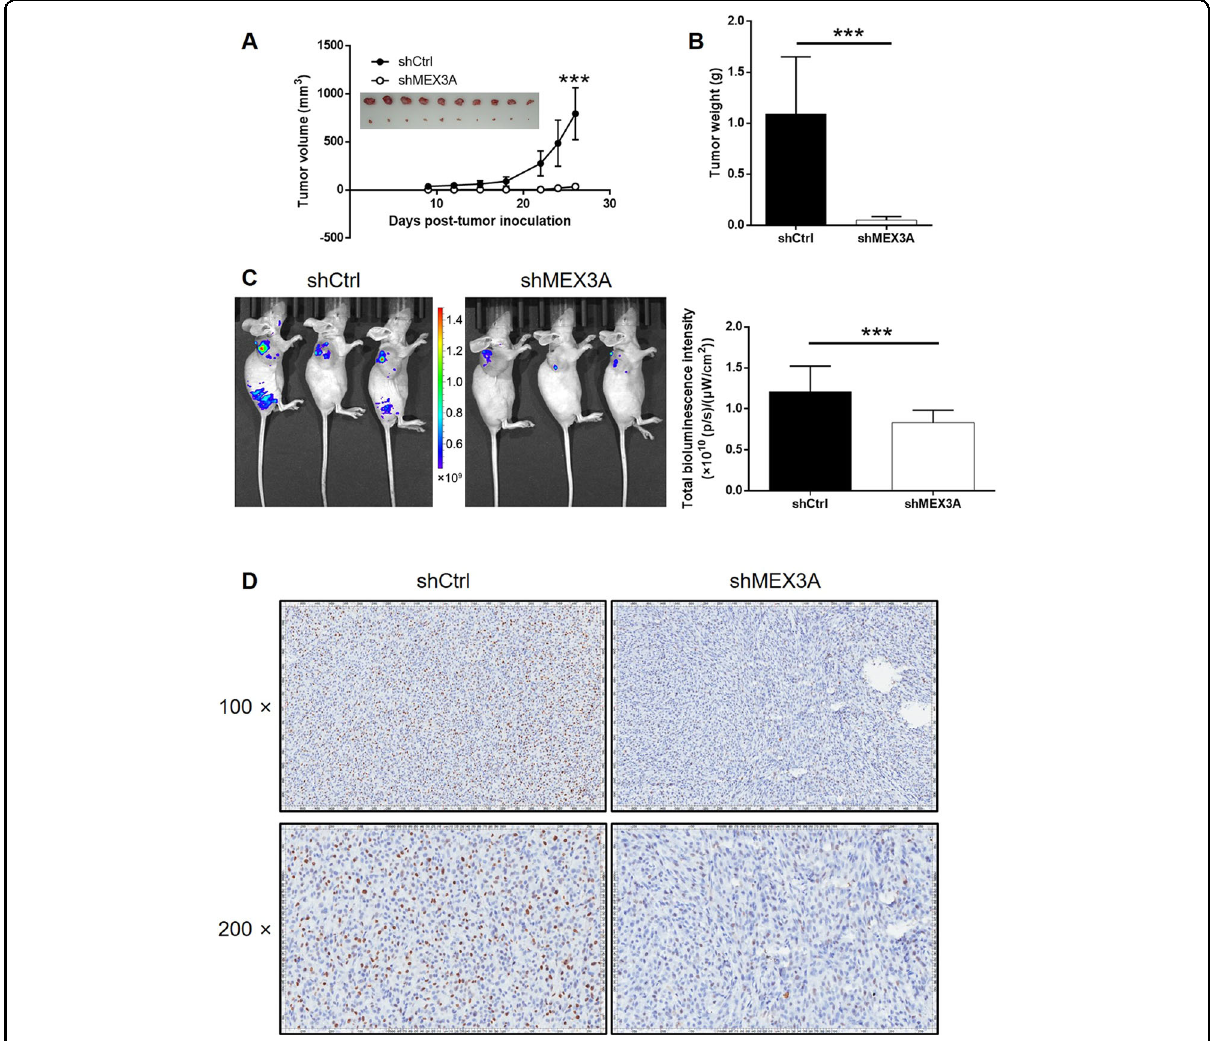
Fig. 3 MEX3A knockdown inhibited glioma development in vivo. A Seven days post injection of U251 cells with or without MEX3A knockdown, the volume of tumors formed in mice was measured and calculated at the indicated time intervals. Inset: tumors were removed 26 days post injection for collecting photos. B Mice were sacri fi ced at day 26 post injection, and the tumors were removed for weighing. C In vivo imaging was performed to evaluate the tumor burden in mice of shMEX3A and shCtrl groups at day 26 post tumor inoculation. The bioluminescence intensity was scanned and used as a representation of tumor burden in mice of shMEX3A and shCtrl groups. D The expression of Ki-67 was detected by IHC to show the proliferative activity of tumors. Data were shown as mean ± SD. * P < 0.05, ** P < 0.01, *** P <